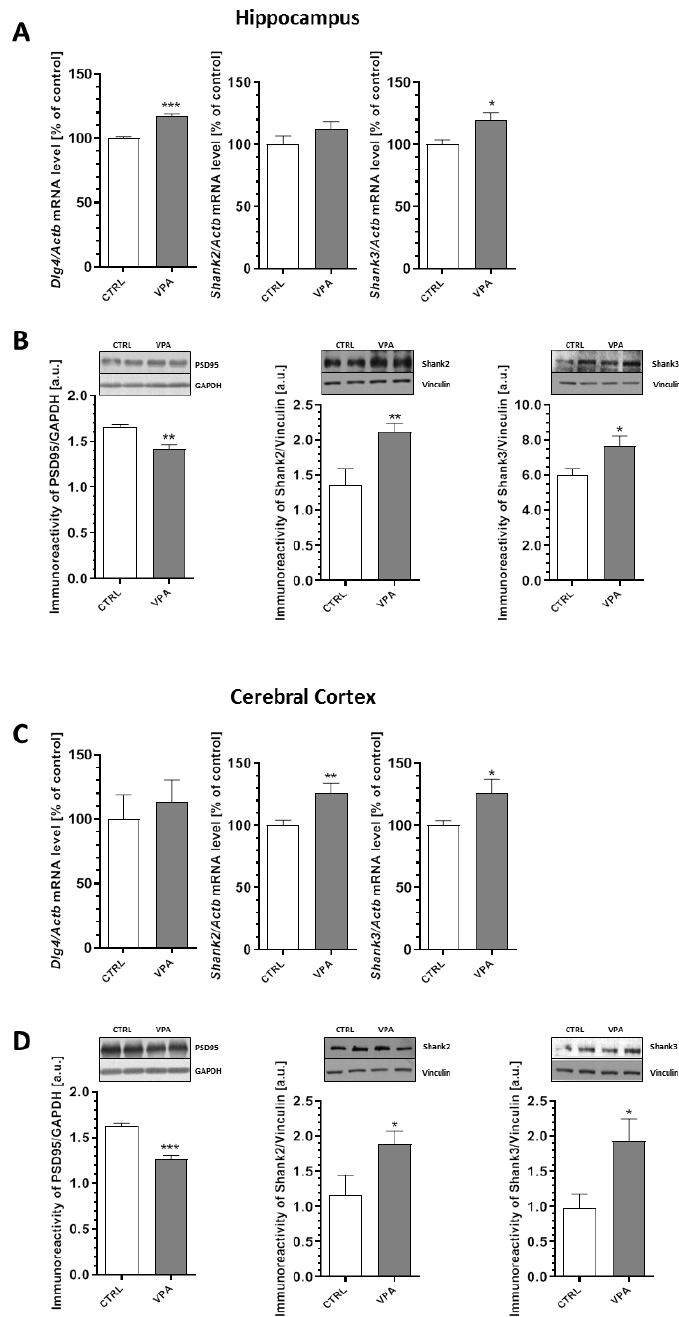
Figure 5. The e ff ect of prenatal exposure to VPA on the expression of the postsynaptic density proteins: PSD95, Shank2, and Shank3. The gene expression of Dlg4, Shank2, and Shank3 in the hippocampus ( A ) and cerebral cortex ( C ) of the control and VPA-exposed rats was measured by quantitative RT-PCR and calculated by the ∆∆ Ct method with Actb ( β -actin) as a reference gene. Data represent the mean values ± SEM from n = (4–5) independent experiments in the hippocampus and n = (4–8) in cortex. The immunoreactivity of the postsynaptic density proteins in the control and VPA-exposed rats was monitored using Western blot analysis. Densitometric analysis and representative pictures for PSD95, Shank2, and Shank3 in the hippocampus ( B ) and cerebral cortex ( D ) are presented. The results were normalized to GAPDH or vinculin levels. Data represent the mean values ± SEM from n = (4–9) independent experiments in both the hippocampus and cerebral cortex. * p < 0.05, ** p < 0.01, *** p < 0.001 vs.